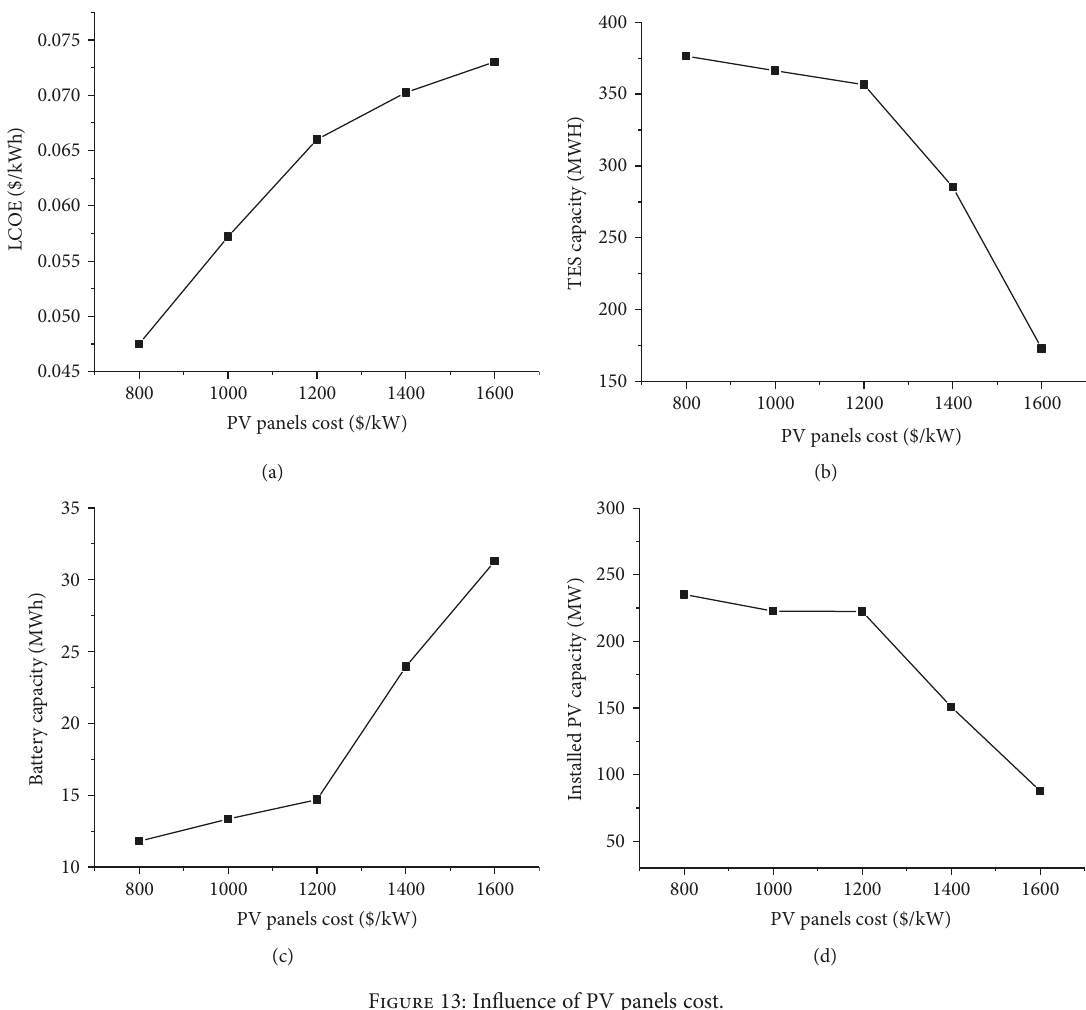
Figure 13: In fl uence of PV panels